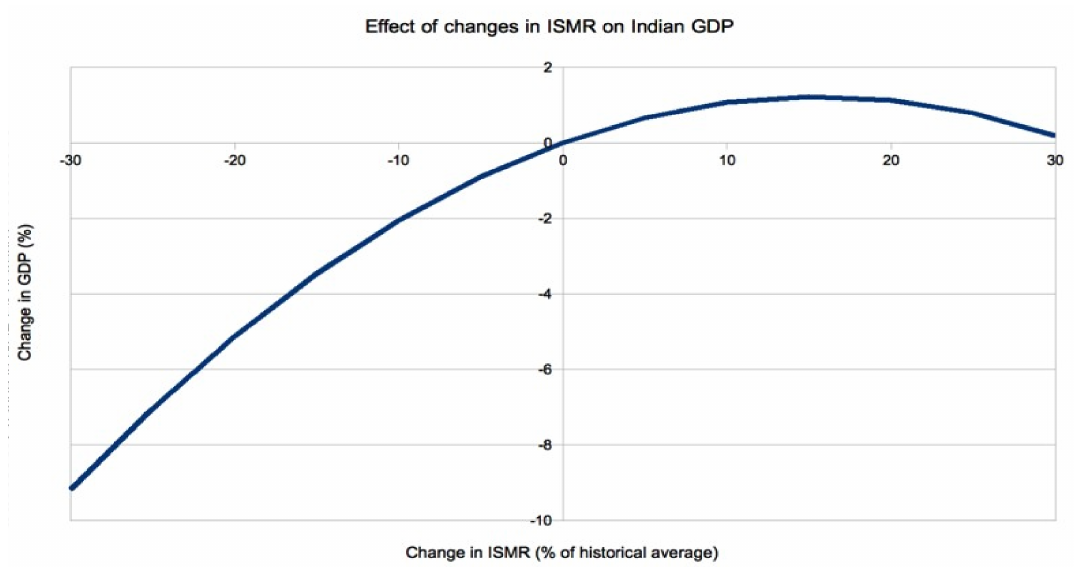
Figure 2. Relationship between ISMR and Indian GDP (redrawn from Gadgil and Gadgil [14]). IGDP is the percentage change in India’s GDP (as a %) and AnomISMR is the deviation (in %) of ISMR from the historical average, a = − 0.005 and b = 0.1565.